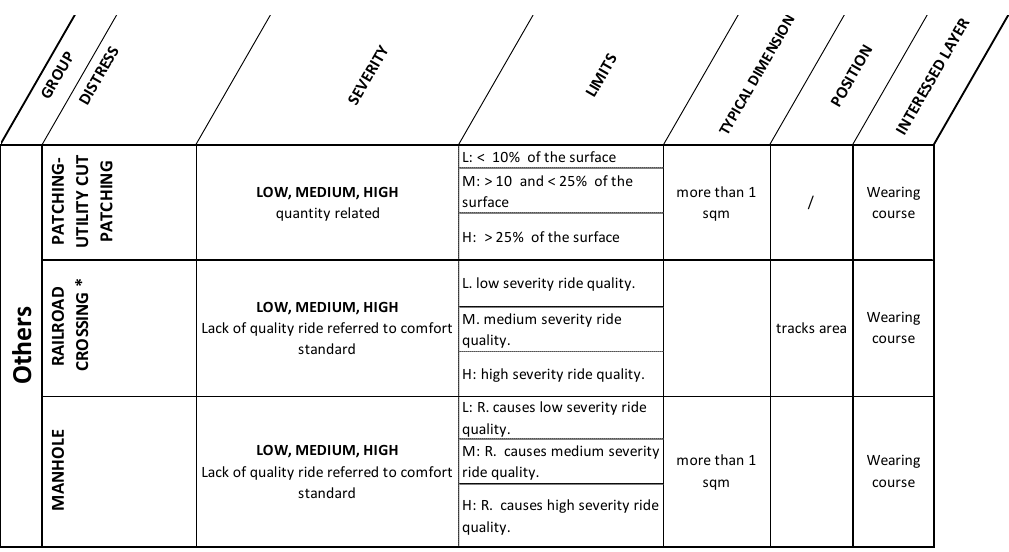
Figure A3. Surface defect Group.